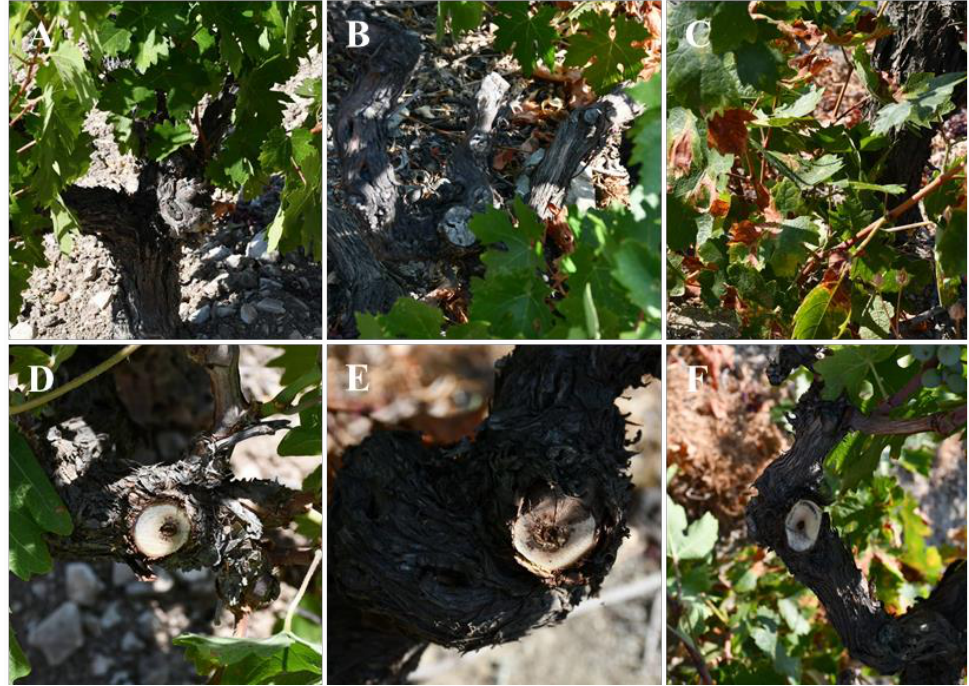
Figure 9. Symptoms observed on leaves, cordons, and trunks of grapevines (goblet-shaped) from isolations made from vineyards in Cyprus. ( A , B ) Dead spurs, and cordons. ( C ) Chlorotic and necrotic spots on leaves. ( D – F ) Trunk cross sections of vines ( A – C ) showing wedge-shape and brown-black streaks.